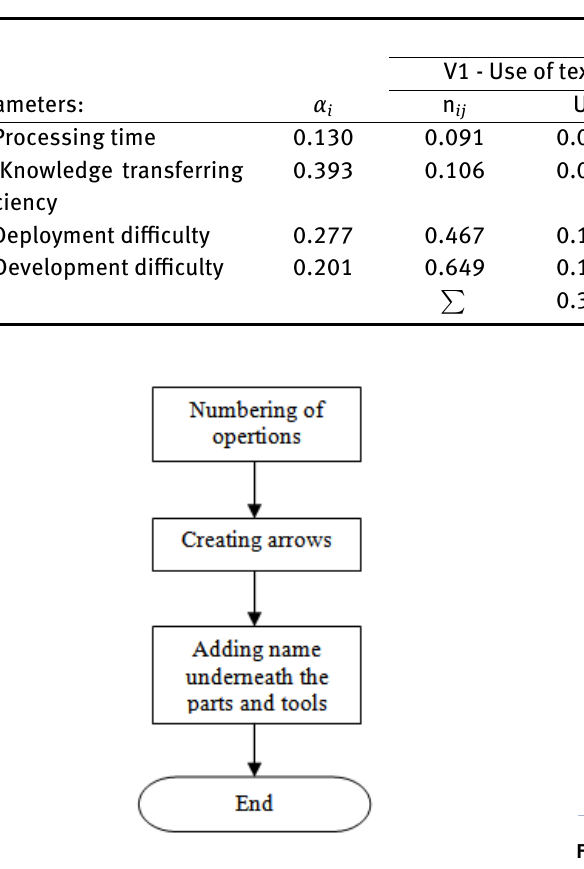
Figure 9: Third part of a flowchart.